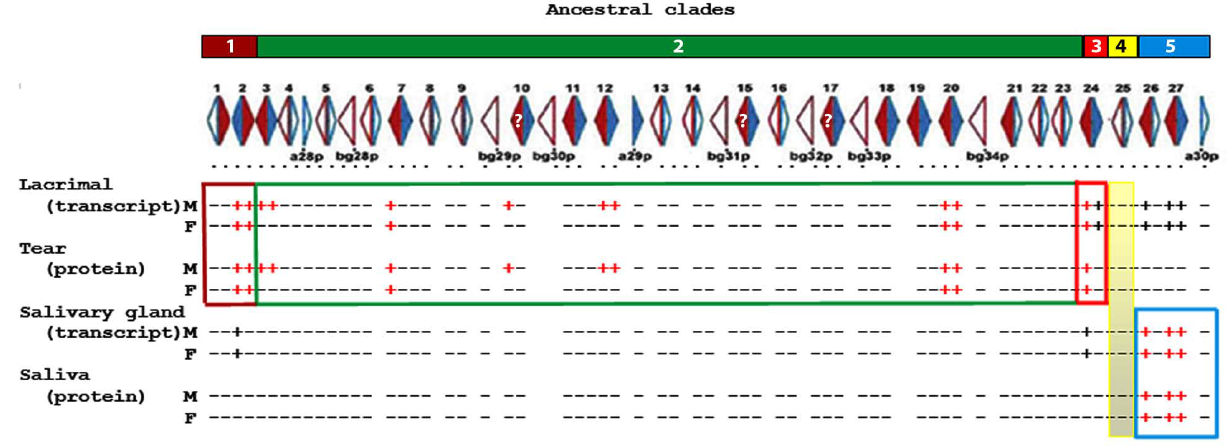
Fig. 1. Distribution of lacrimal gland/tear and salivary gland/saliva Abp expressions by ancestral clade. The five ancestral clades [8] are shown at the top as numbered, colored blocks. The complete map of Abp genes with arrows depicting genes ( Abpa in blue, Abpbg in red) appears below the clade blocks with solid filled arrows showing complete (potentially expressed) genes and open arrows showing putative pseudogenes. , Abpa-Abpbg . and , Abpbg- Abpa . modules are numbered above the linkage map [8]. Gene expressions for transcripts in lacrimal and salivary glands and proteins in tears and saliva are scored as + / 2 and appear below the linkage map. Those positive as both PCR products from gland cDNA libraries that could be sequenced (i.e. transcripts) and proteins in the glandular secretion appear as red + signs; those found only as transcripts that could be sequenced appear as black +